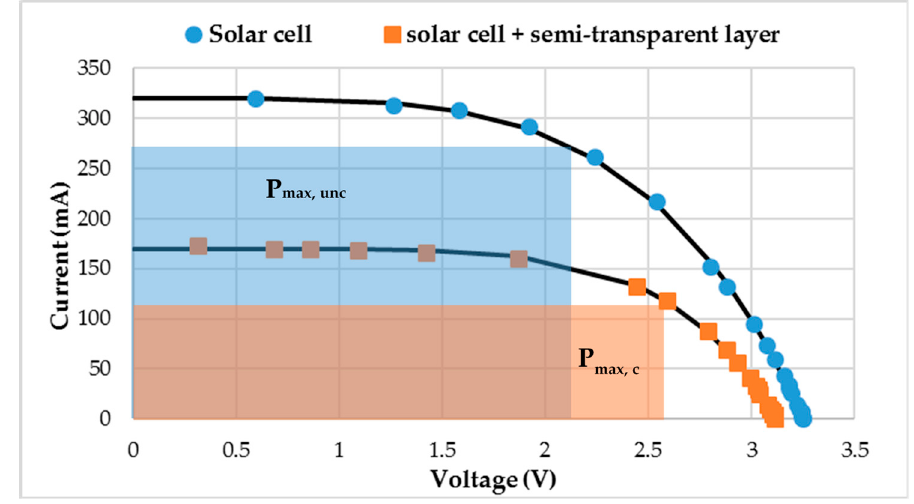
Figure 4. Example of intensity-voltage curve.